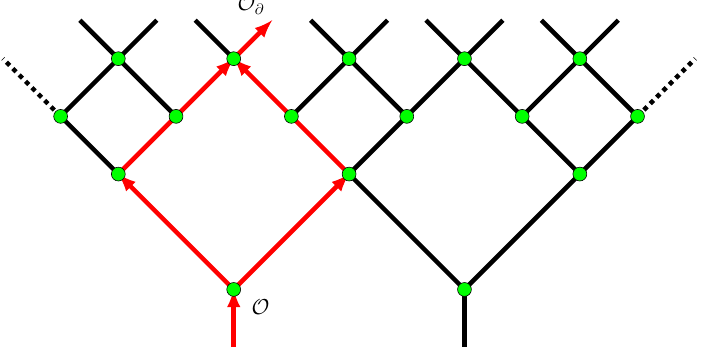
Figure 4. Linear operator pushing on a generic tensor network. The red paths indicate all the paths joining the bulk operator and the boundary